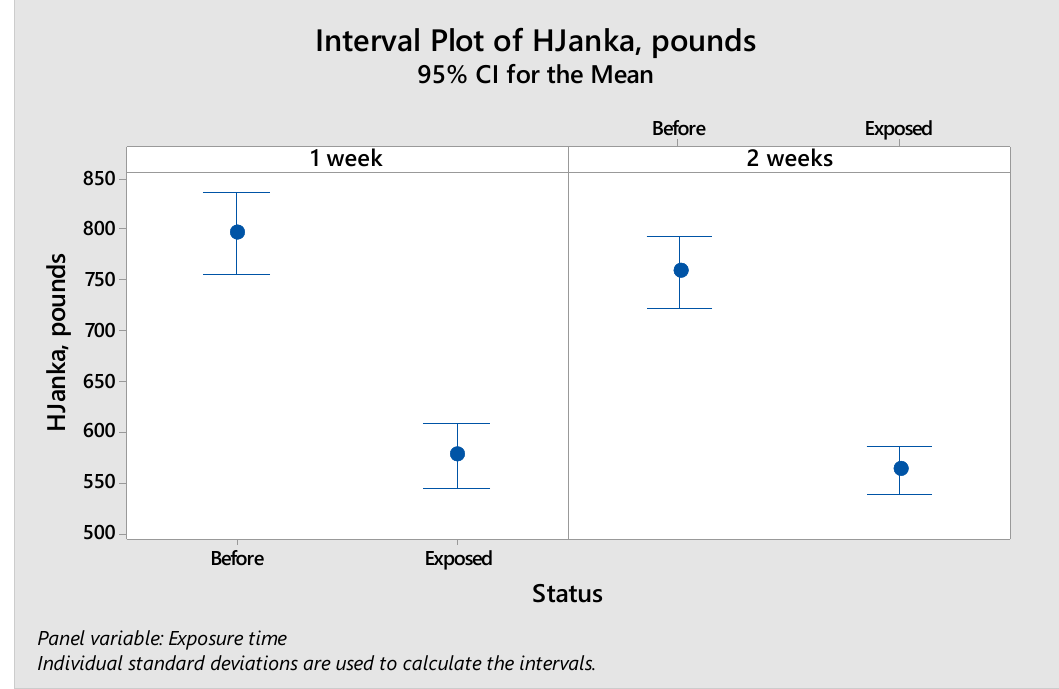
Figure 7. Variation of the Janka hardness of the raw PB samples, before and after exposure to humidity conditions. Coatings 2019 , 9 , x FOR PEER REVIEW